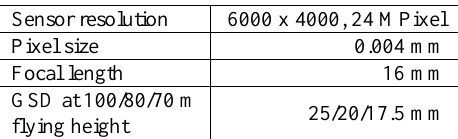
Table 1. Main characteristics of the Sony Alpha-6000 camera adopted